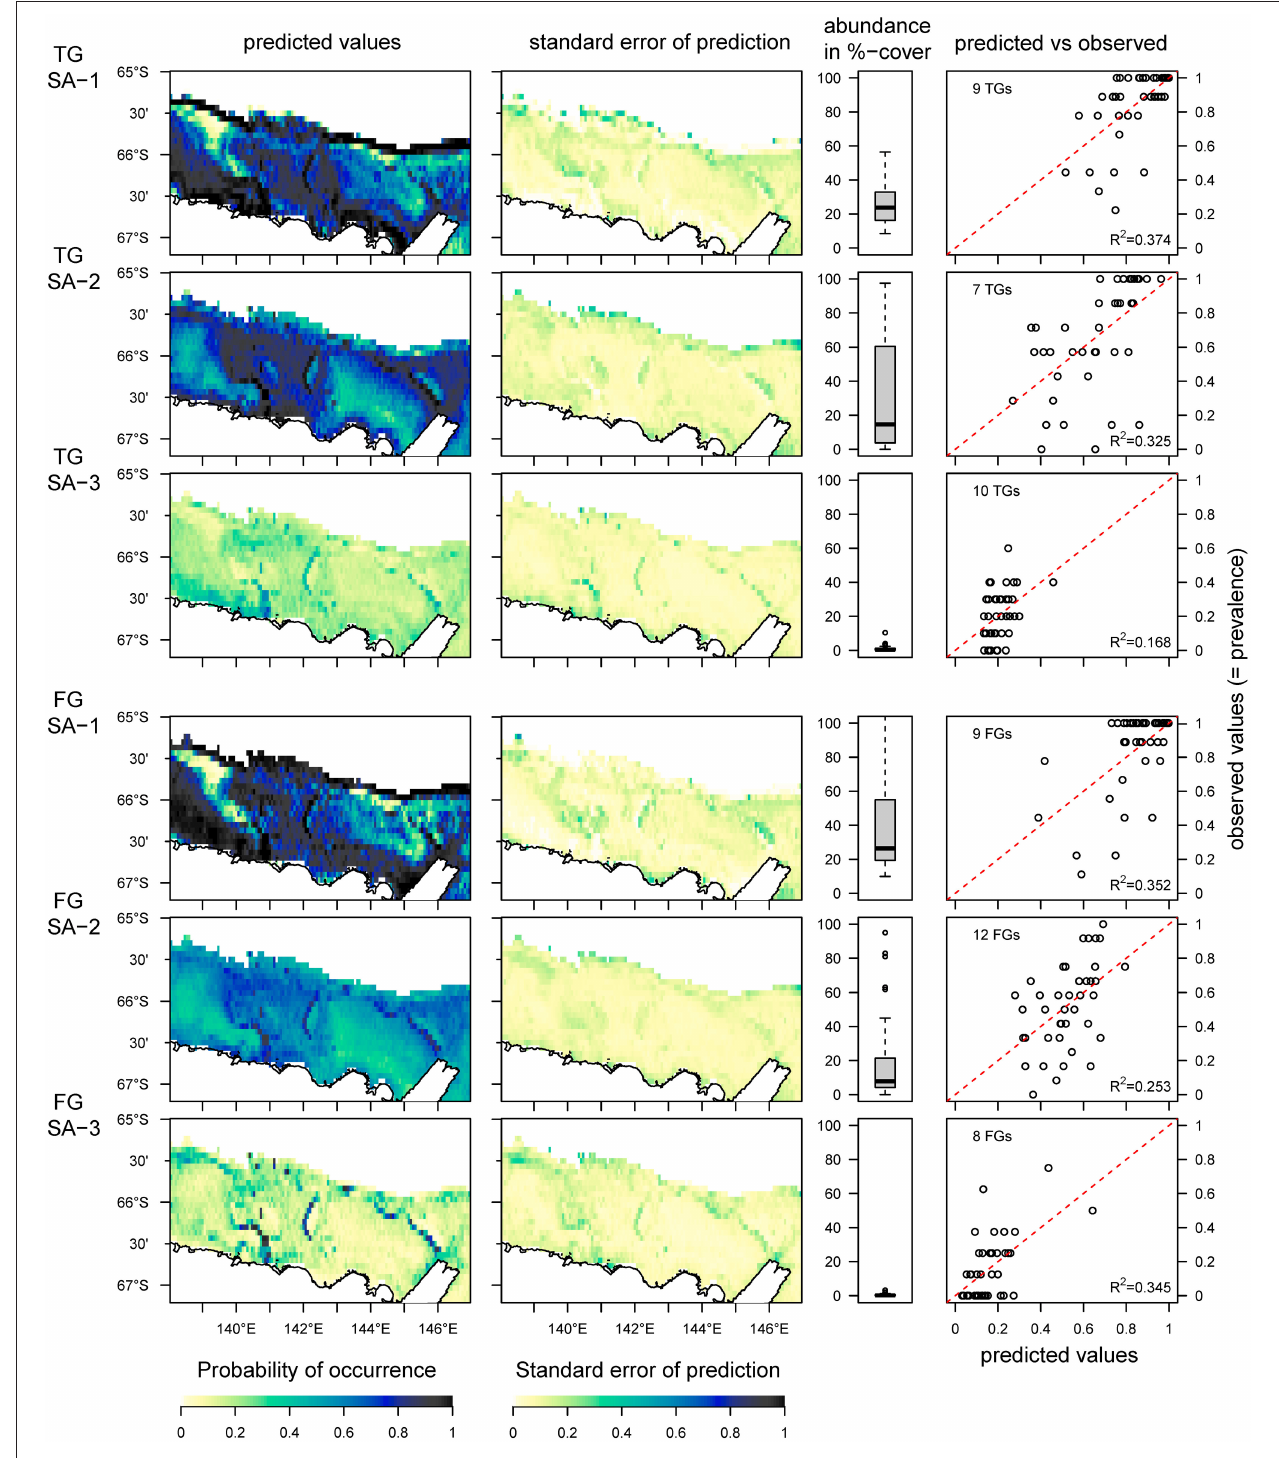
FIGURE 5 | Predicted distribution of species archetypes (SA) identified from the taxonomic (TG) and functional group (FG) datasets, the standard error of the prediction, the total abundance of all OTUs combined within each SA and the relationship between predicted and observed values. The red dotted line indicates the 1:1 line between predicted and observed values; the R 2 -value is for a linear regression between observed and predicted values. The predictions are based on data from 41 sites, and the area under the Mertz Glacier Tongue is excluded from the predictions.